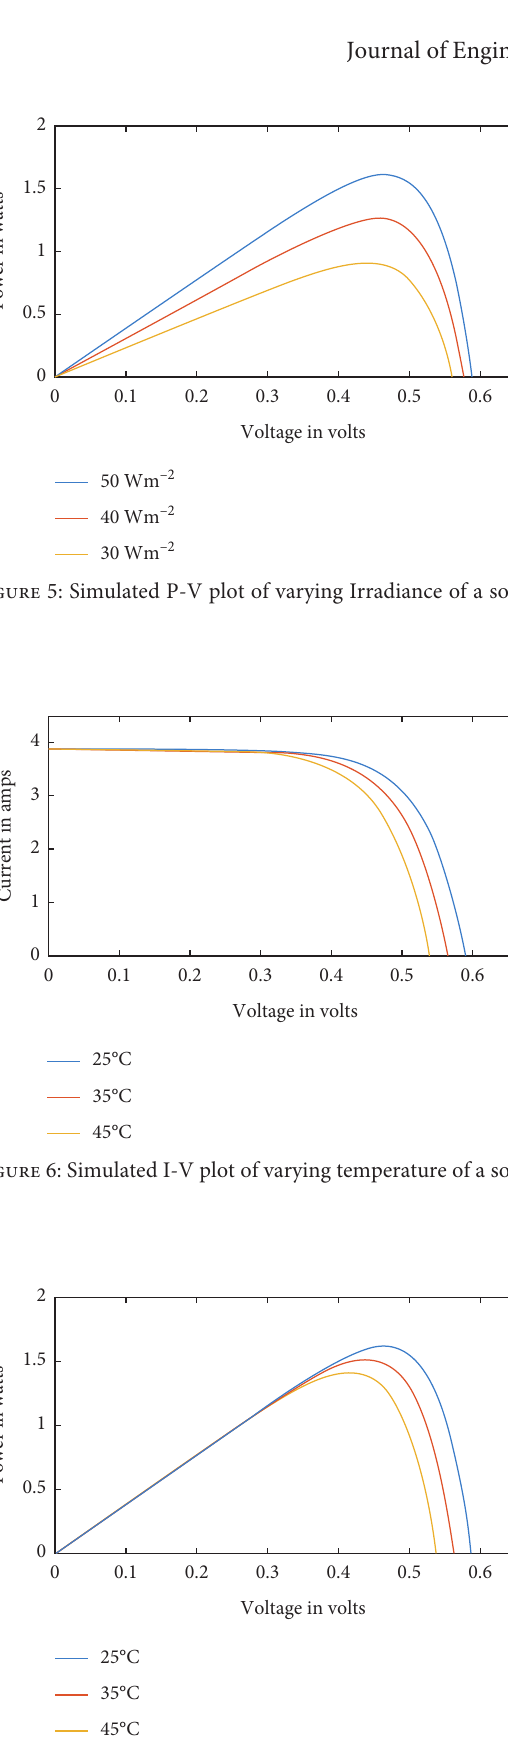
Figure 7: Simulated P-V plot of varying temperature of a solar